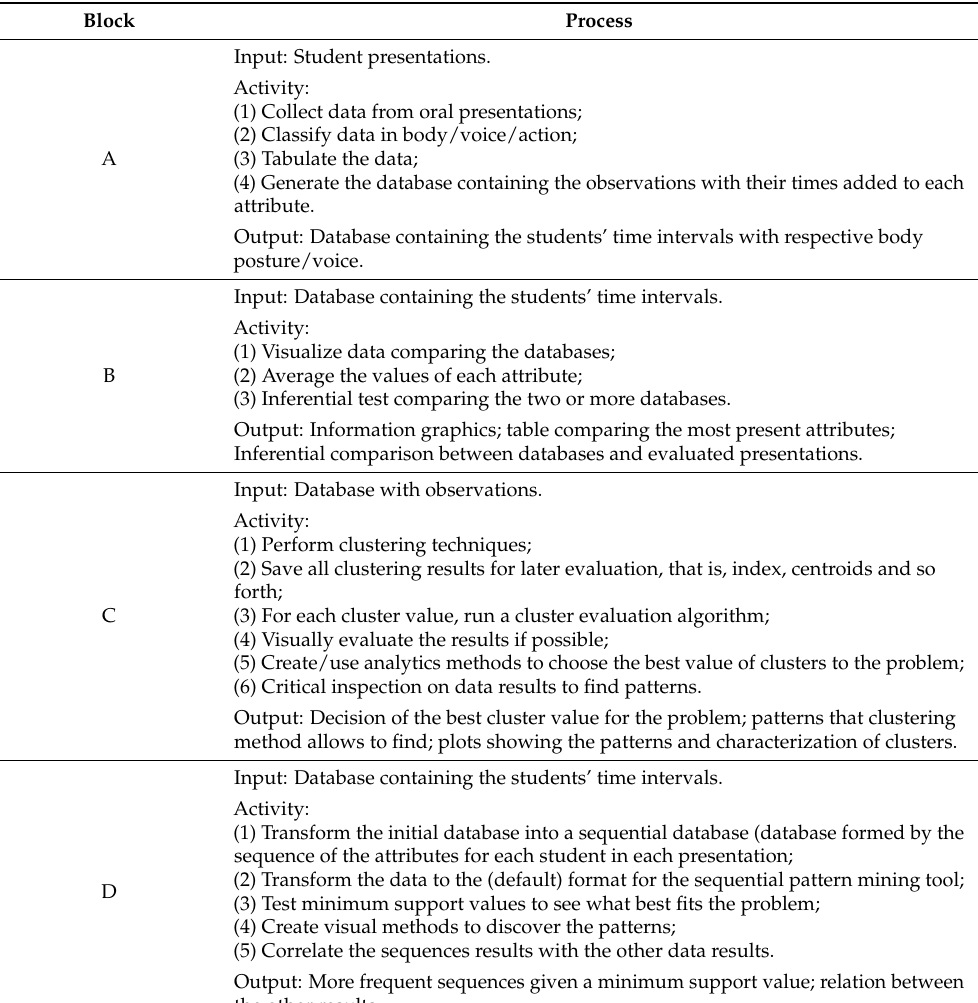
Table 1. Details of the grouped framework